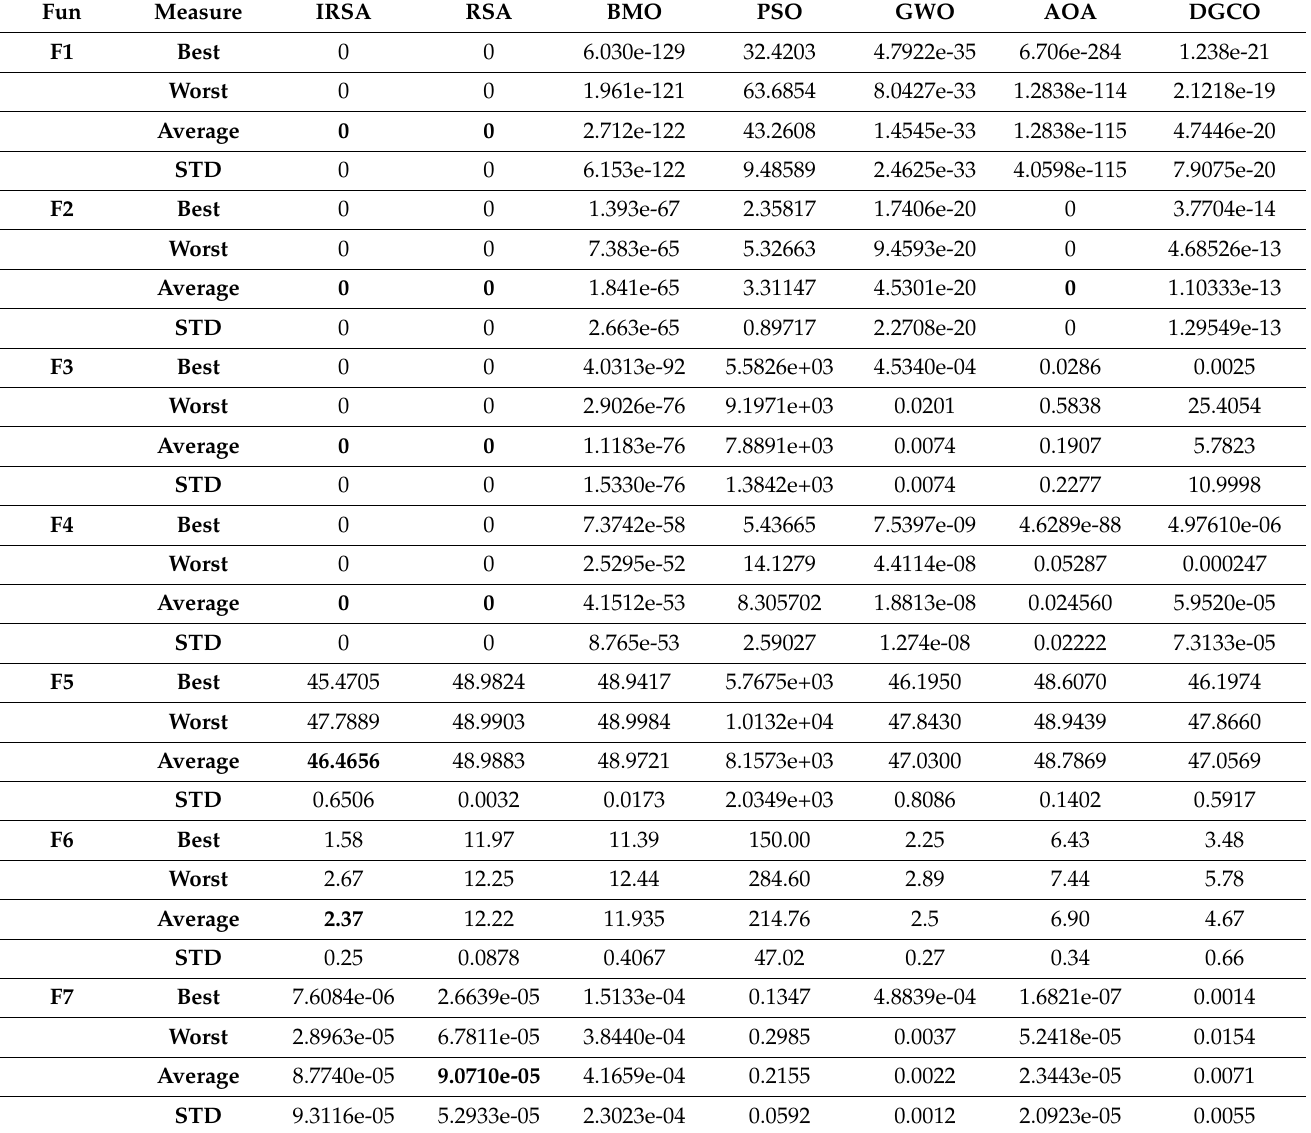
Table 1. Results for unimodal and multimodal functions for 50 dimensions, 500